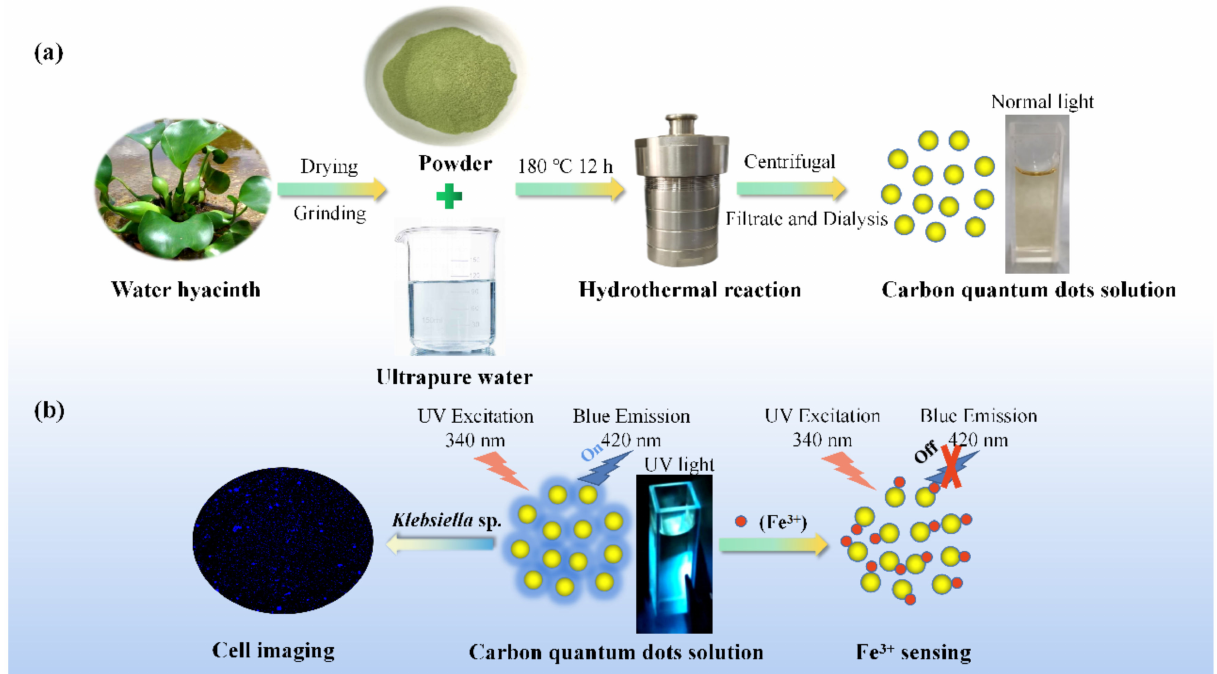
Figure 1. ( a ) Schematic of CQDs derived from wh and ( b ) their